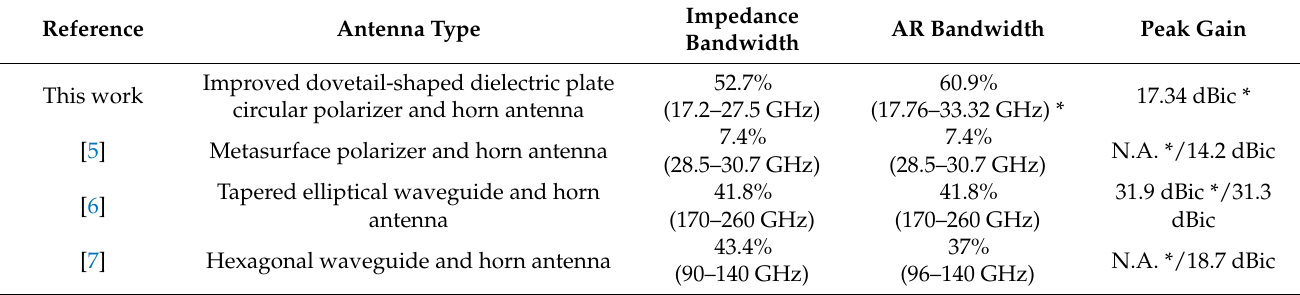
Table 1. Comparisons of the antenna performance with previously proposed